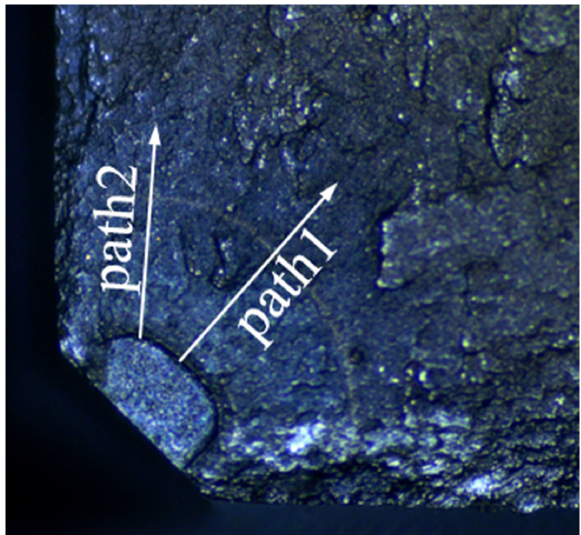
Figure 19. Two paths to measure the crack propagation rate.